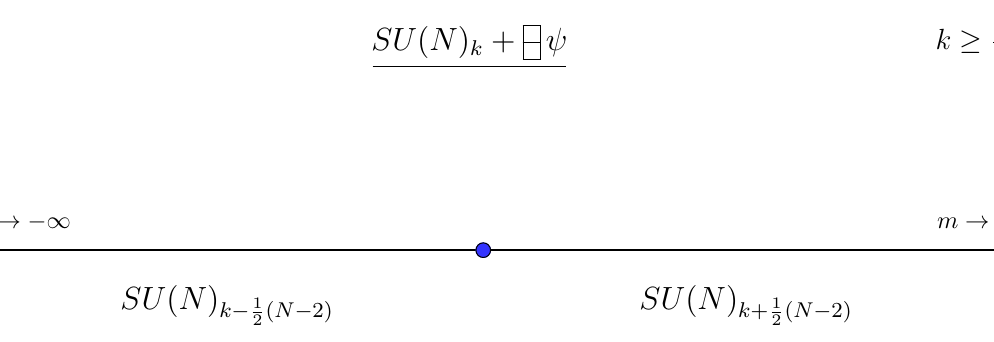
Figure 1 . Phase diagram of SU( N ) gauge theory with a symmetric fermion for k (cid:21) N +2 solid circle represents a phase transition between the asymptotic phases. For su(cid:14)ciently large k we know for certain that the phase transition is associated with a CFT.